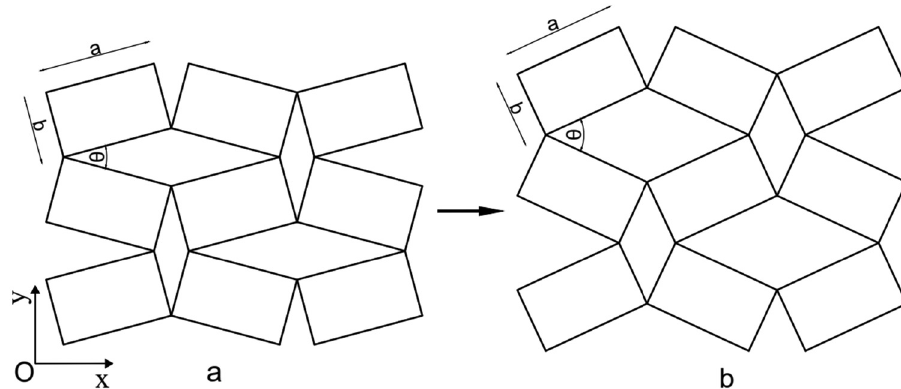
Figure 1: Rotating rigid rectangular structure: ( a ) the original structure; ( b ) the stretched